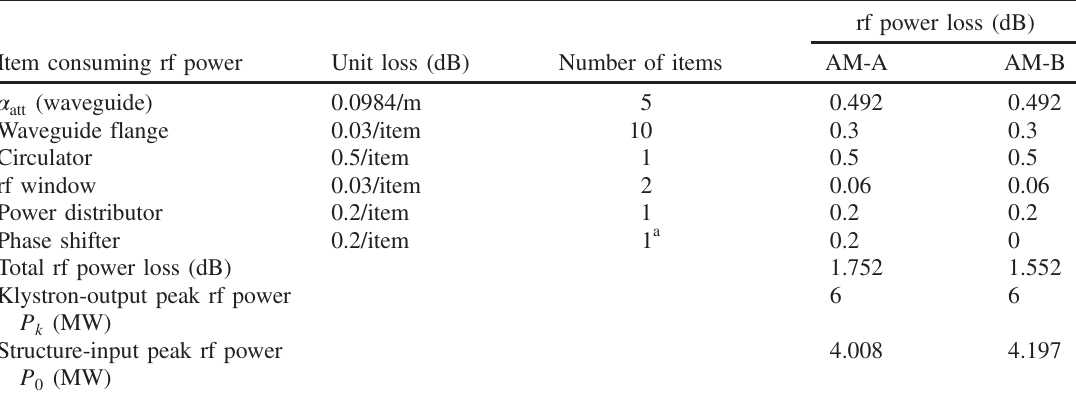
TABLE IV. rf power losses in the X -band microwave circuit.